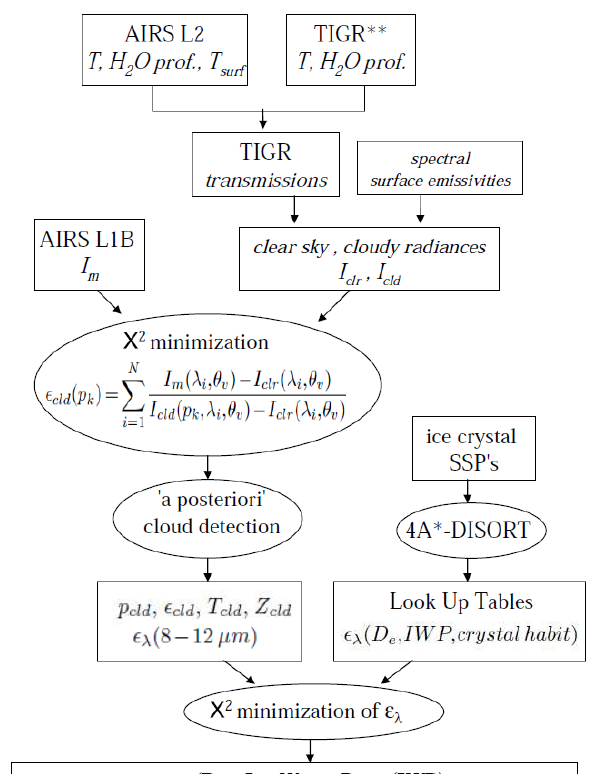
Fig. 1. LMD cloud property retrieval Fig.1. LMDcloudpropertyretrievalscheme